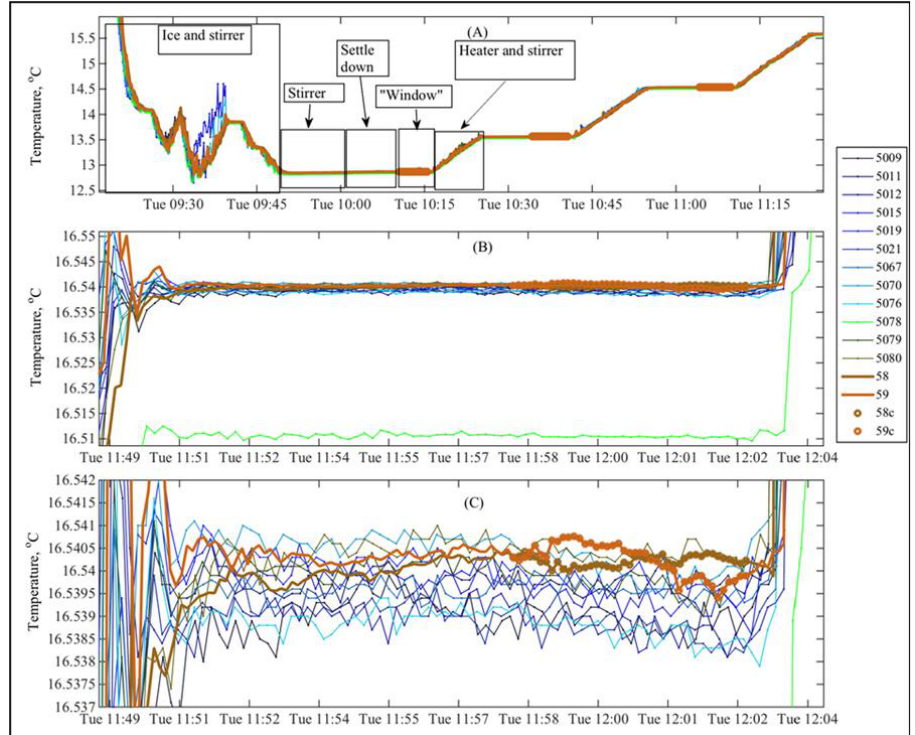
Figure 5. Panel ( A ) summarizes the temperature calibration procedure for 12 SBE 37 IM CT sensors. Panel ( B ) shows all sensors ’ data that were collected during a calibration step. Panel ( C ) is the same as panel ( B ), only zoomed in for clarity. Bold lines denote the reference sensors and cycles denote the readings that belong to a calibration “window”. Table 4. The uncertainty of the temperature